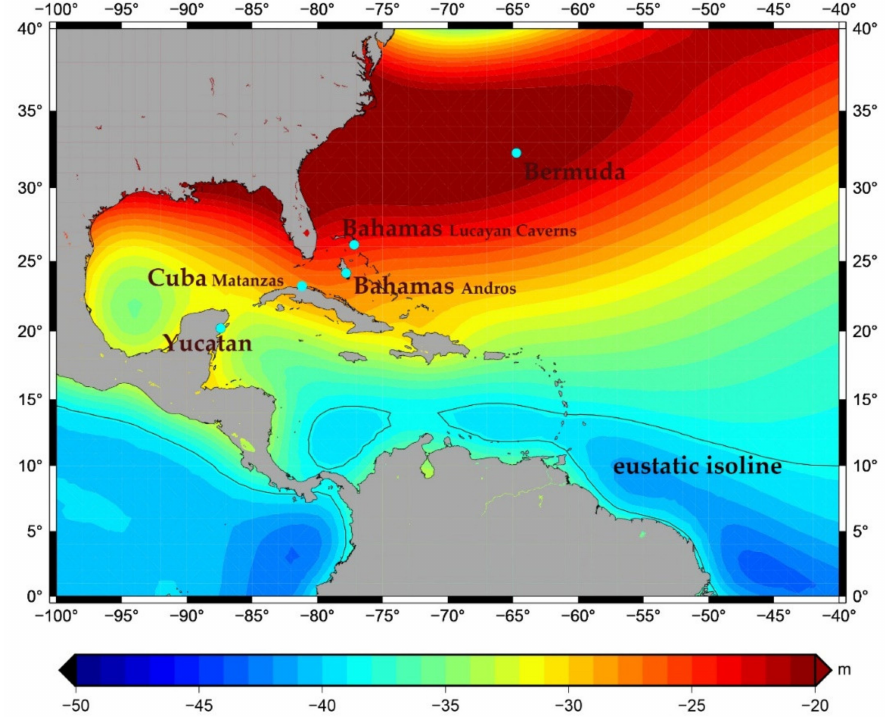
Figure 16. Predicted RSL elevation in the Caribbean Sea during MIS 5.3 according to ANICE-SELEN and the MVP 3 mantle viscosity profile. The light blue dots indicate the location of the sites. The black isoline shows the eustatic value ( − 38.81